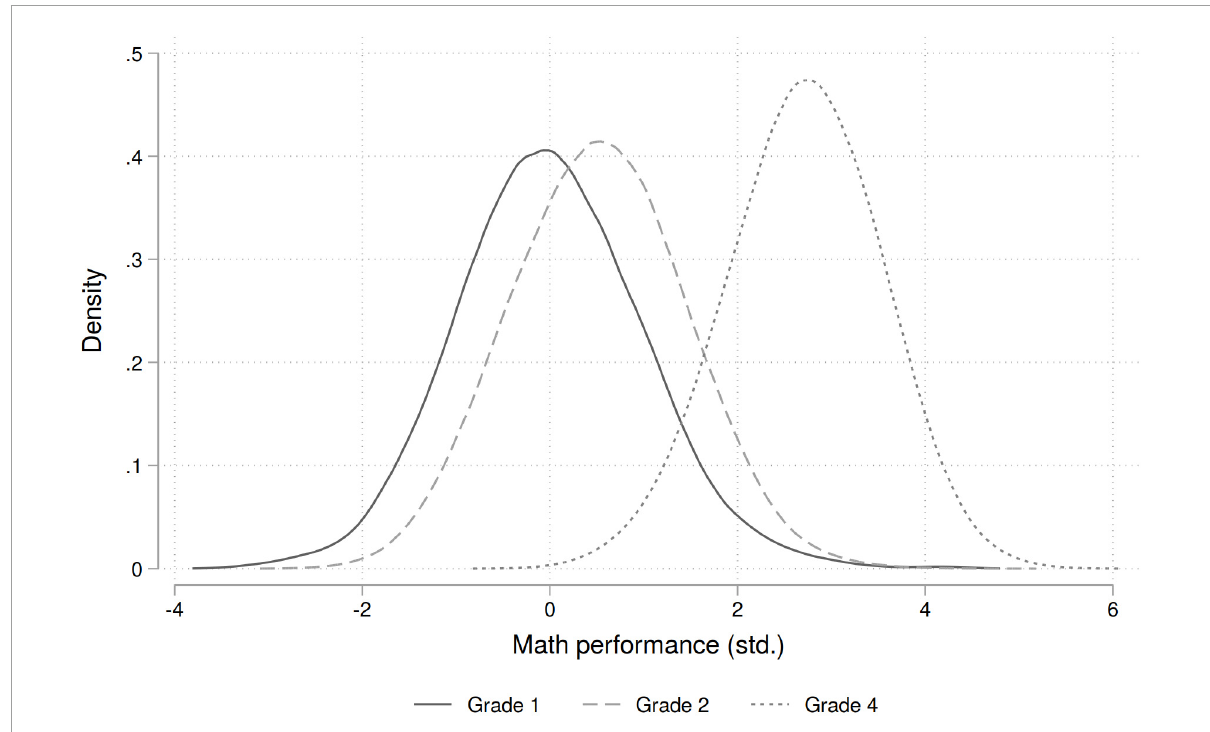
FIGURE2 Distribution of math competencies by grade. Source: NEPS SC2, imputed data. Competencies are standardized by grade